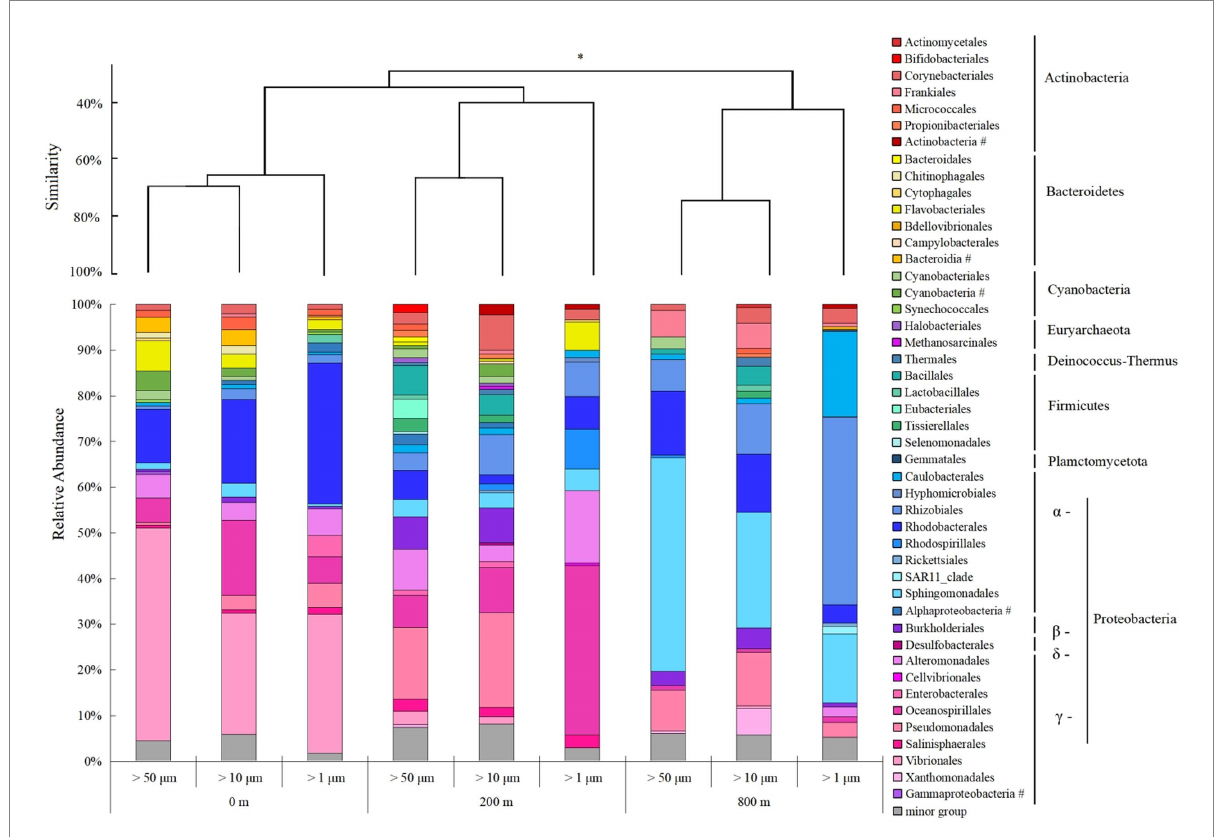
FIGURE 4 Microbial community structure of different size-fraction particles in different water depths at the order level with cluster at the phylum level. * p < 0.05, #